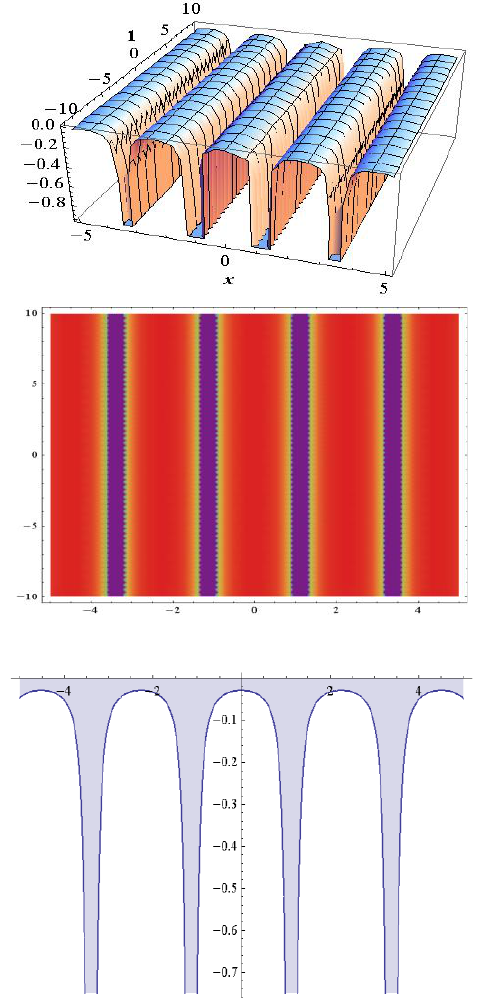
Figure-2. The 3D, density graphic and 2D surfaces of